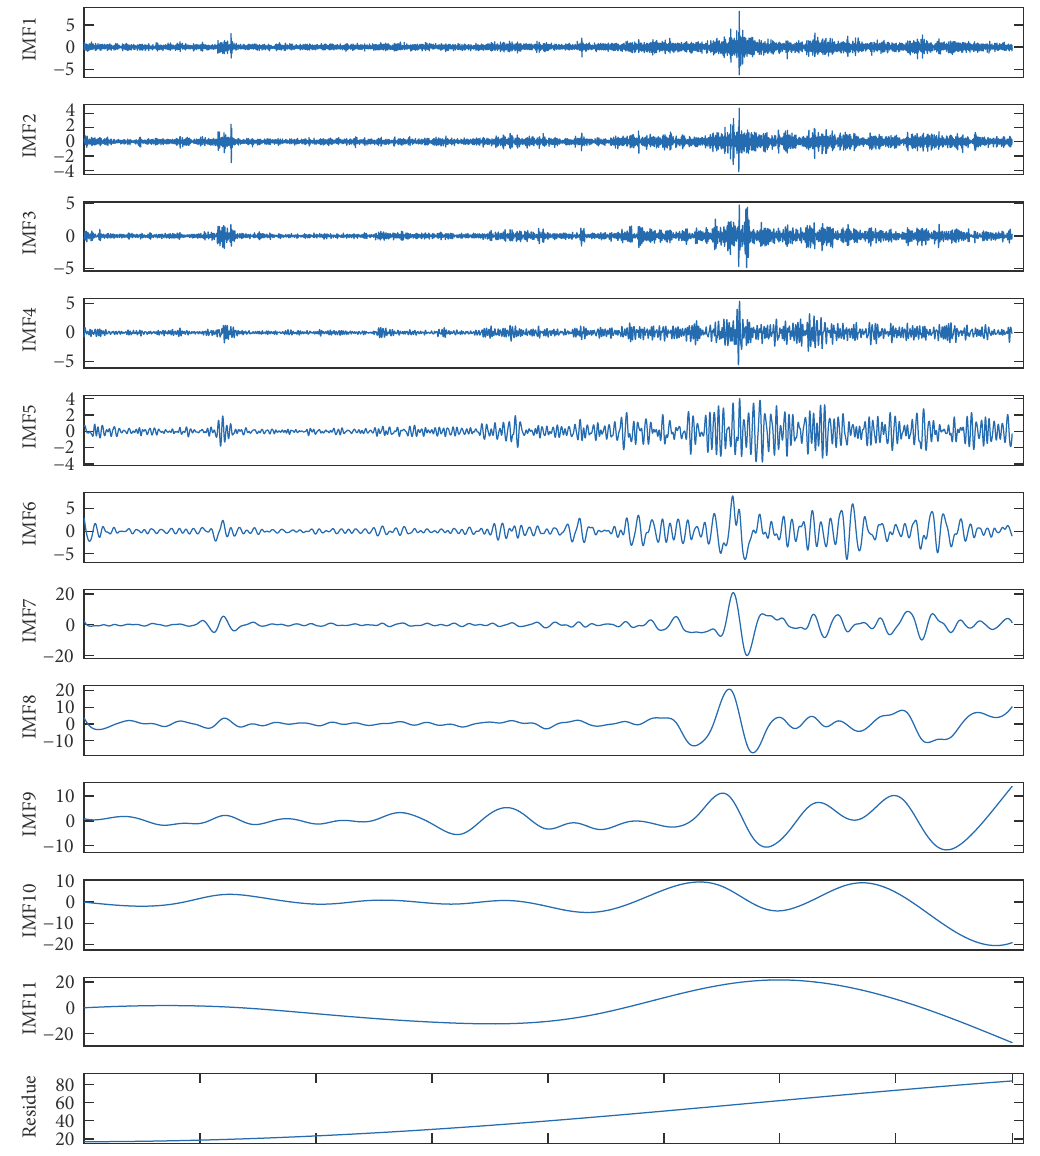
Figure 4: The IMFs and residue of WTI crude oil prices by EEMD.